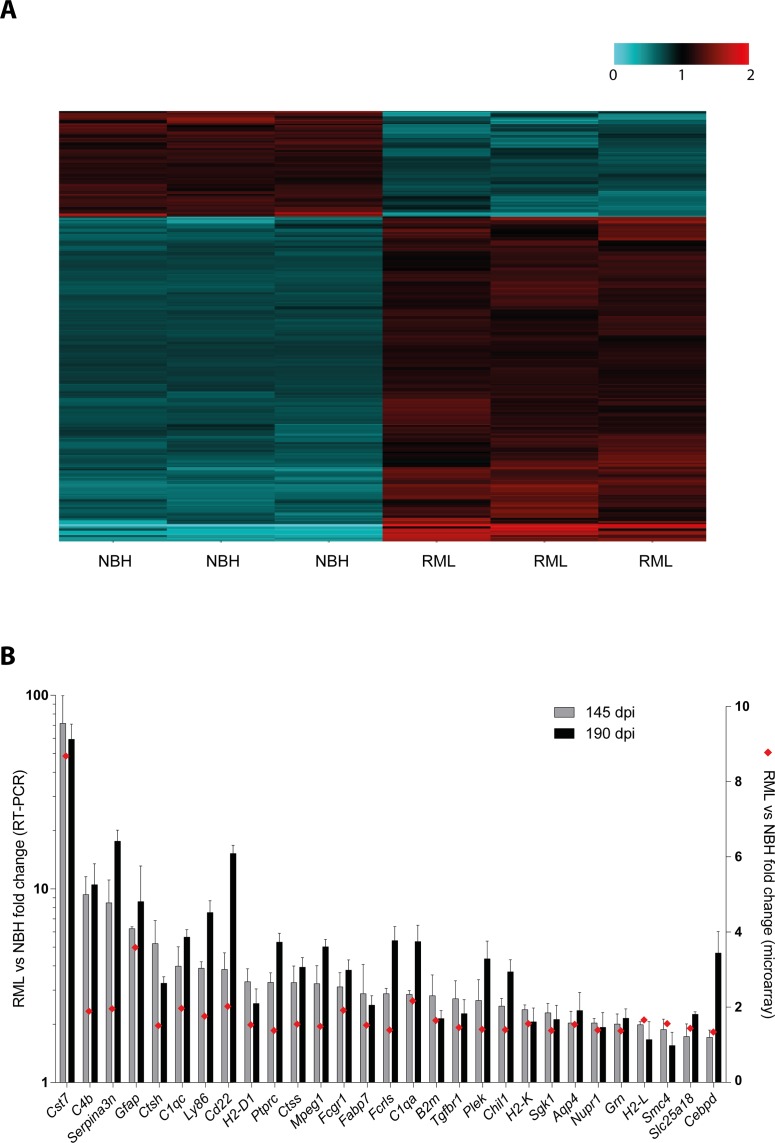
Microarray analysis identifies Cst7 as the most upregulated transcript in RML inoculated mice.A Heatmap showing relative expression of 251 differentially expressed genes (absolute fold change ≥1.3, a confidence interval >90% and Student’s t test p value <0.05) between RML prion-inoculated mice (RML, n = 3, A to C) and control mice injected with non-infectious brain homogenates (NBH, n = 3, A to C). For each gene, relative expression is defined as the ratio between the actual gene expression of each mouse and the average gene expression from all 6 analyzed mice (the latter set as 1, black) and is reported as grades of blue (downregulation) or red (upregulation). Expression data were obtained through the employment of the perfect match mismatch model-based expression analysis algorithm of microarray data previously reported in [6]. The list of differentially expressed genes is reported in S4 Table. B Validation of the upregulation of 29 transcripts (including Cst7) in RML-inoculated mice (n = 3) compared to NBH-injected controls (n = 3). Bars (left y axis) depict mean and standard deviation of transcript fold change expression between brains of RML-inoculated mice and NBH-injected controls (after normalization to Actb levels) at 145 and 190 days post-inoculation (dpi), as assessed by RT-PCR. Red diamonds (right y axis) depict transcript fold change expression between brains of RML-inoculated mice and NBH-injected controls at 145 dpi as assessed by microarray.